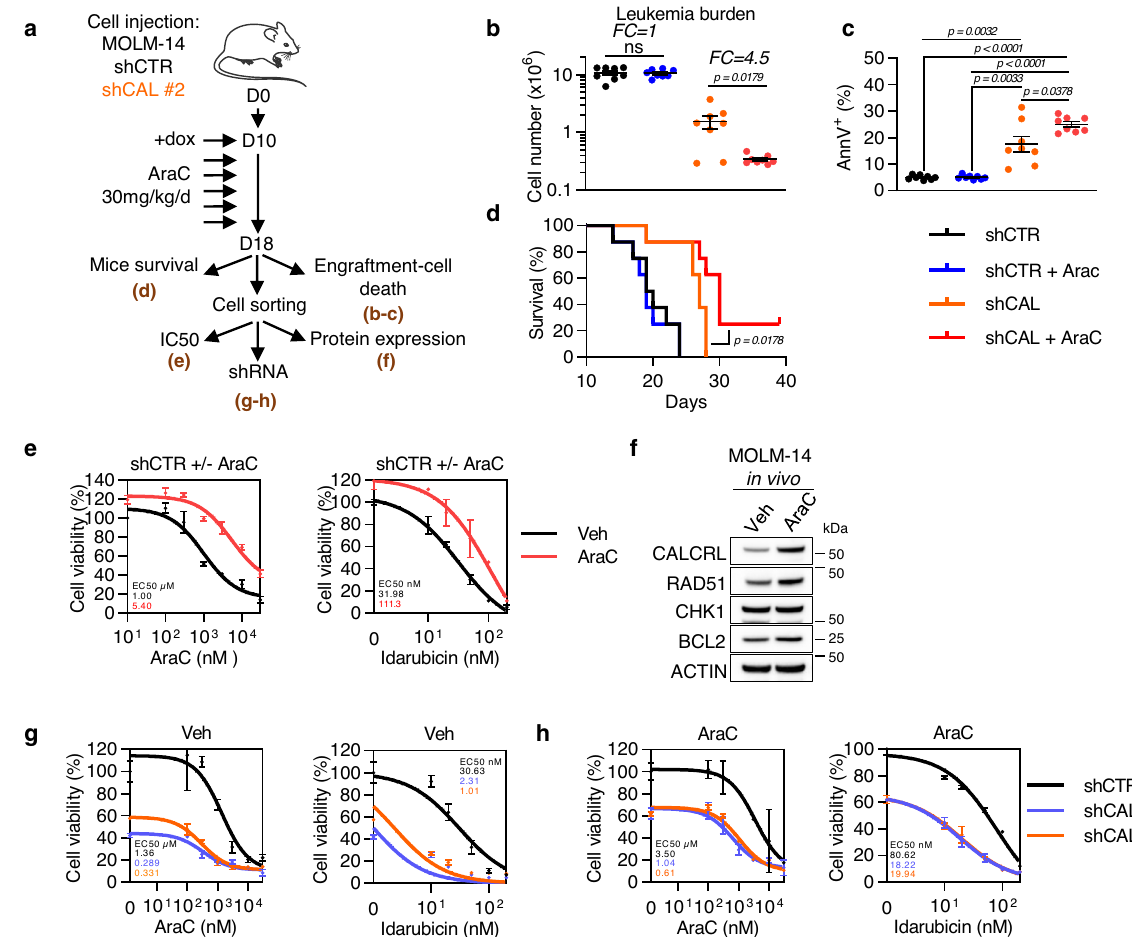
Fig. 6 Depletion of CALCRL sensitizes AML cells to chemotherapy in vivo. a Experimental plan for assessing the consequence of CALCRL depletion on chemotherapy response in vivo. 2×10 6 MOLM-14 expressing indicated inducible shRNAs were injected into the tail vein of NSG mice. Ten days later, when disease was established, mice were treated with 30mg/kg/d AraC for 5 days. On day 18, a group of mice was kept to follow survival ( d ). The other group was sacri fi ced to assess human cell engraftment ( b ) and cell death ( c ). Human cells were also sorted by fl ow cytometry using mCD45.1 − /hCD45 + /hCD33 + /AnnV − markers and replated in culture dishes to assess protein expression ( f ), sensitivity to chemotherapeutic drugs ( e ), and to perform CALCRL depletion by shRNA ( g, h ). b Total leukemia burden measured using mCD45.1 − /hCD45 + /hCD33 + /AnnV − markers (unpaired t- test). c Graph shows the percentage of AnnV + cells (unpaired t -test). d Mice survival monitoring (Log-rank (Mantel-Cox) test). e After replating, cells were treated with AraC or idarubicin ex vivo for 48h. Cell viability was assessed by MTS assay and values were normalized to untreated condition ( n = 1 in quadriplate). Curve fi t to calculate IC50 was determined by log (inhibitor) vs response (three parameters). f Western blotting for CALCRL, RAD51, CHK1, BCL2, and β -ACTIN. Cellular extracts were collected 2 days after mice sacri fi ce. g, h Human cells from vehicle ( g ) or AraC ( h ) treated mice were transduced with indicated shRNA. After 4 days cells were treated with AraC or idarubicin for 48h and cell viability was assessed by MTS assay ( n = 1 in quadriplate). Curve fi t to calculate IC50 was determined by log (inhibitor) vs response (three parameters) test. Data are